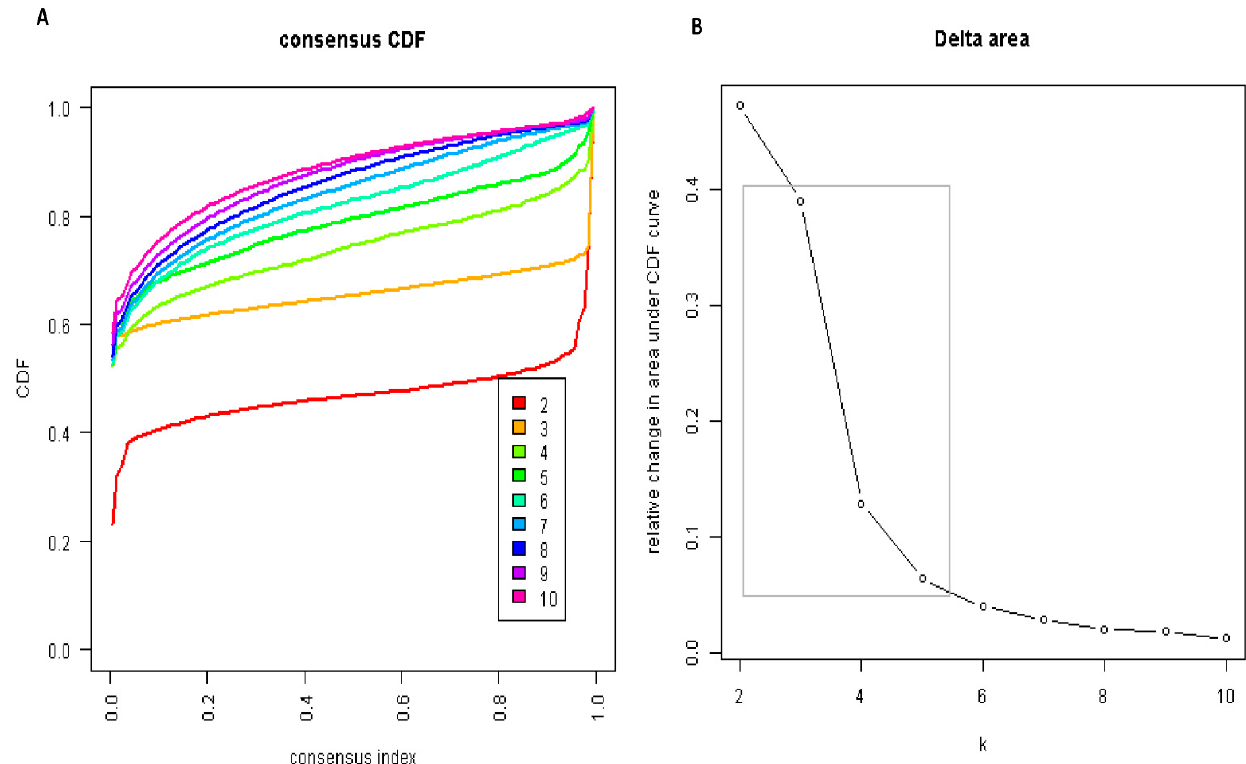
Figure 1. ( A ) CDF plot displaying consensus distributions for each cluster (k) for ICU patients with lactic acidosis; ( B ) Delta area plot reflecting the relative changes in the area under the CDF curve.